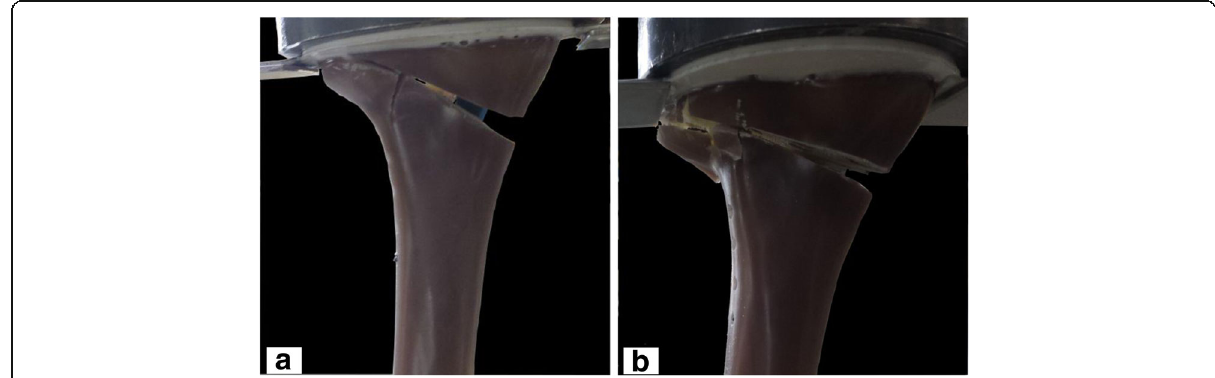
Fig. 3 Fracture of the lateral cortical bone in specimens: ( a ) Activmotion 1 and ( b ) Activmotion 2. The opposite cortex was the weak point of the specimens